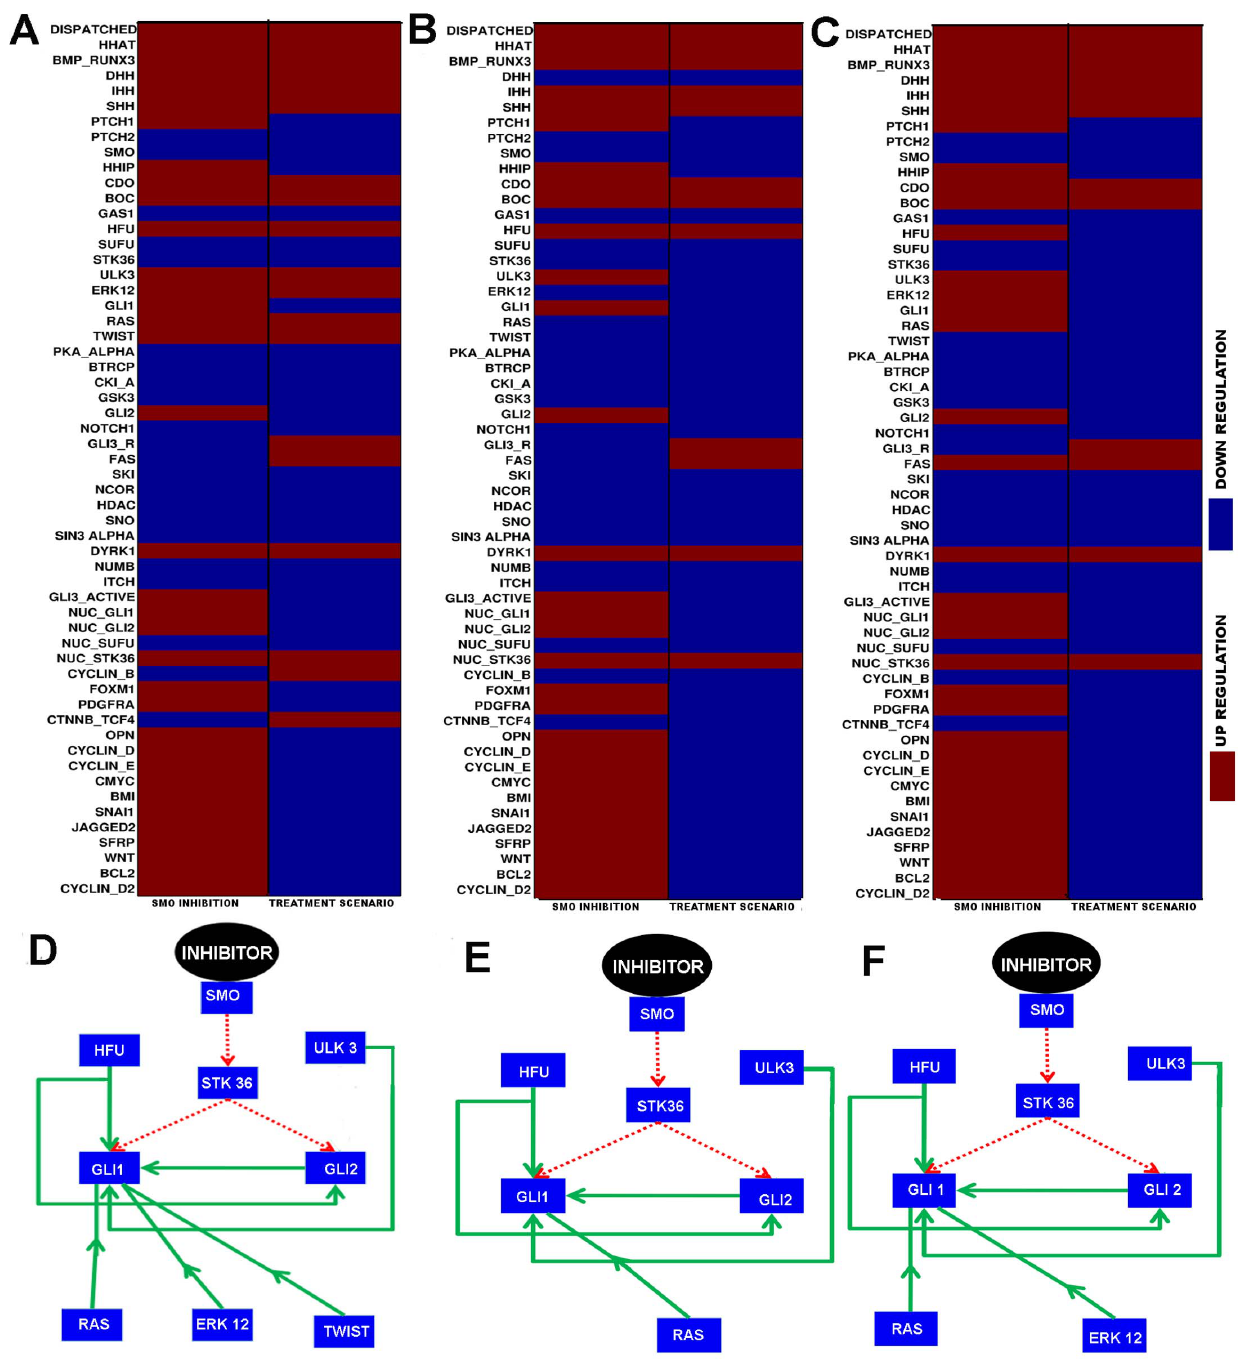
Figure 8. Protein expression levels observed in SMO inhibition and Treatment Scenarios for different cancers. First columns of (A), (B) and (C) represent the expressions of the proteins found after inhibiting SMO in Glioma, Colon and Pancreatic cancer models, respectively. Second columns of (A) represents the expressions of the proteins observed in the treatment scenario by perturbing SMO, GLI1 and GLI2 in combination in the same Glioma model; (B) represents the expressions of the proteins in the treatment scenario by perturbing SMO, HFU, ULK3, and RAS in combination in the same Colon cancer model; (C) represents the expressions of the proteins in the treatment scenario by perturbing SMO, HFU, ULK3, ERK12, and RAS in combination in the same Pancreatic cancer model. (D), (E) and (F) represent the identified alternative pathways (shown by solid green arrows) that remain active even after the inhibition of SMO in membrane (pathway shown by broken red arrows) by its inhibitor molecule (i.e. Cyclopamine, Vismodegib etc. ) in Glioma, Colon and Pancreatic cancer scenarios, respectively. which were still activating the pathway. Our in-silico combinatorial and as a result we proposed a need for combinatorial drug target treatment (i.e. Treatment scenarios) also accounted this constraint therapy to completely shut down the hedgehog pathway activity.